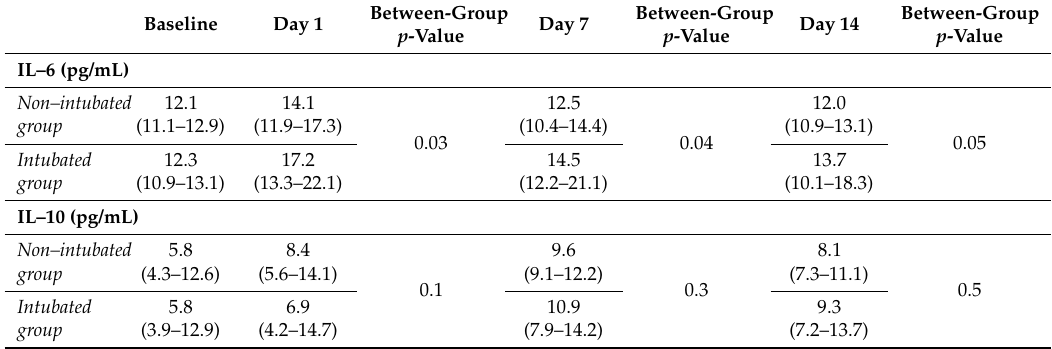
Table 3. Postoperative changes of cytokines. Interquartile ranges are expressed within brackets.